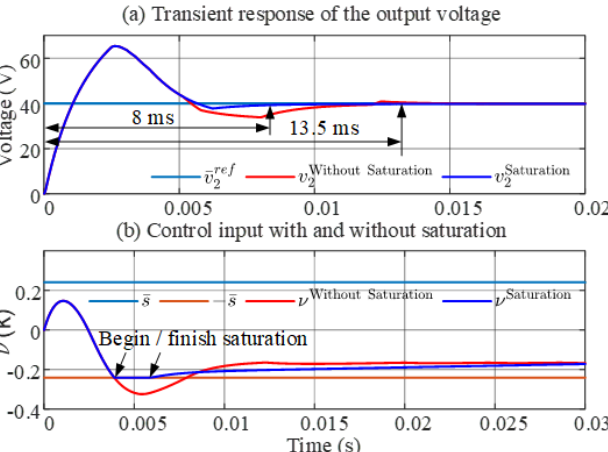
Figure 11. Simulation results of the output voltage when applying with/without input saturation.